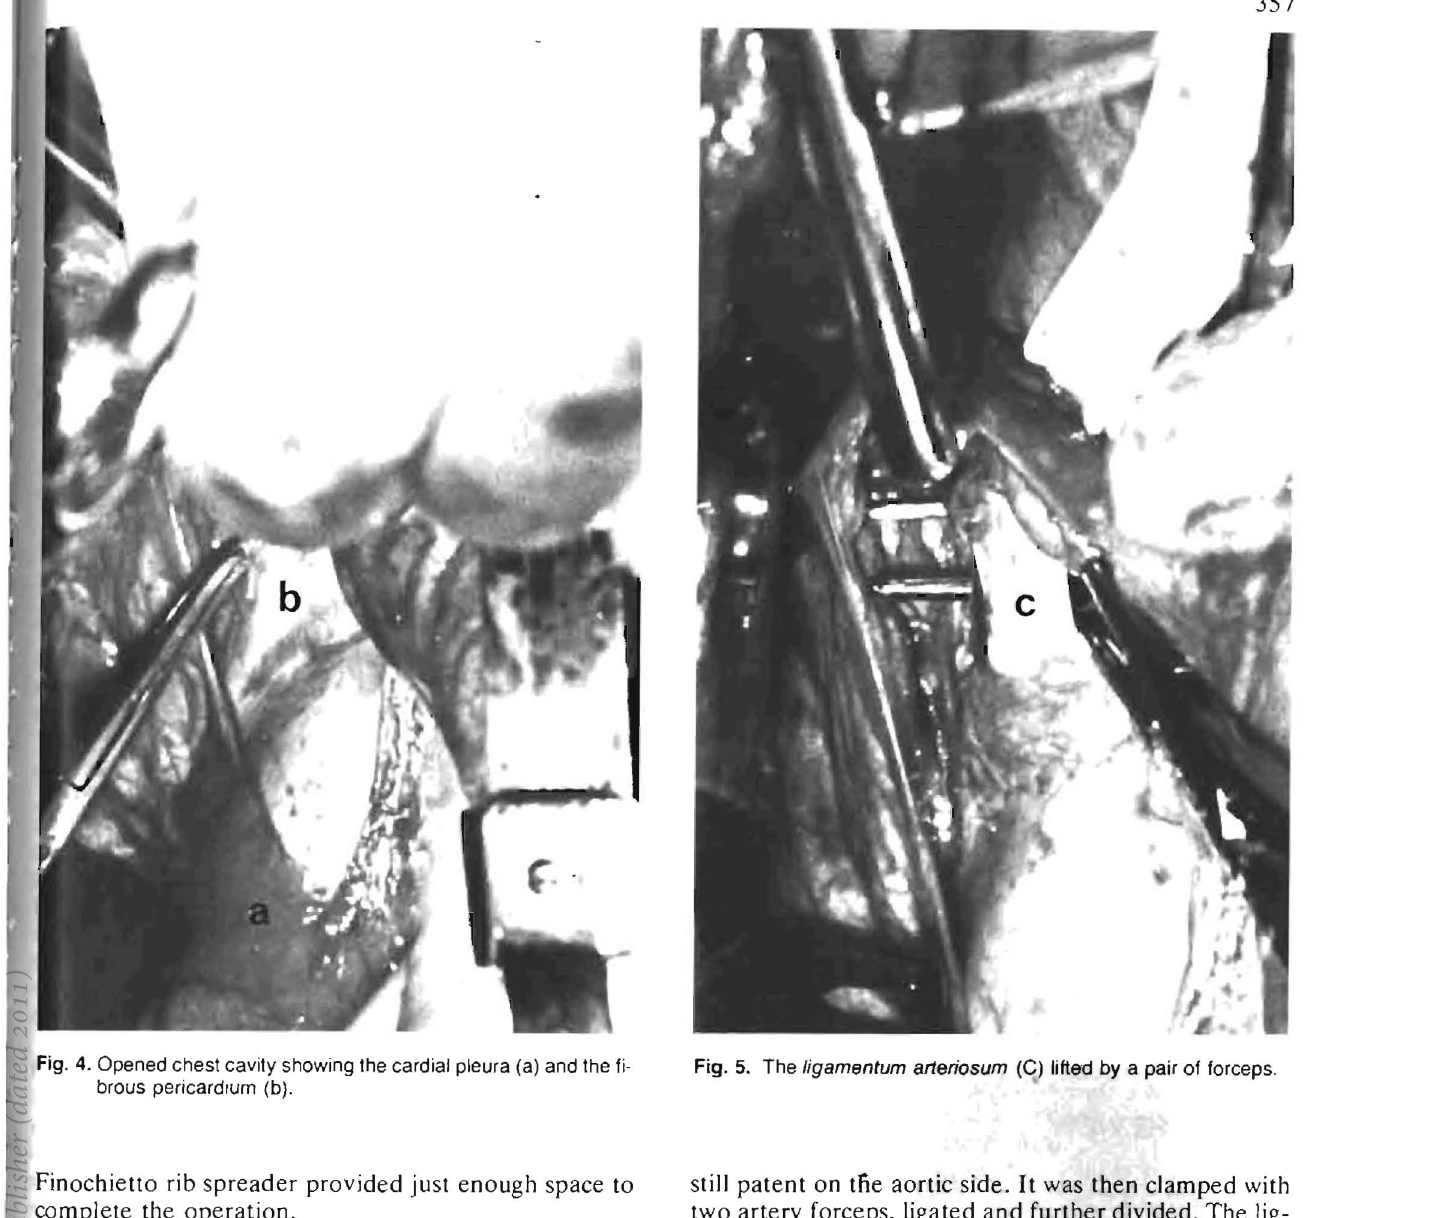
Fig. 4. Opened chest cavity showing the cardial pleura (a) and the fi· brous pericardium (b).